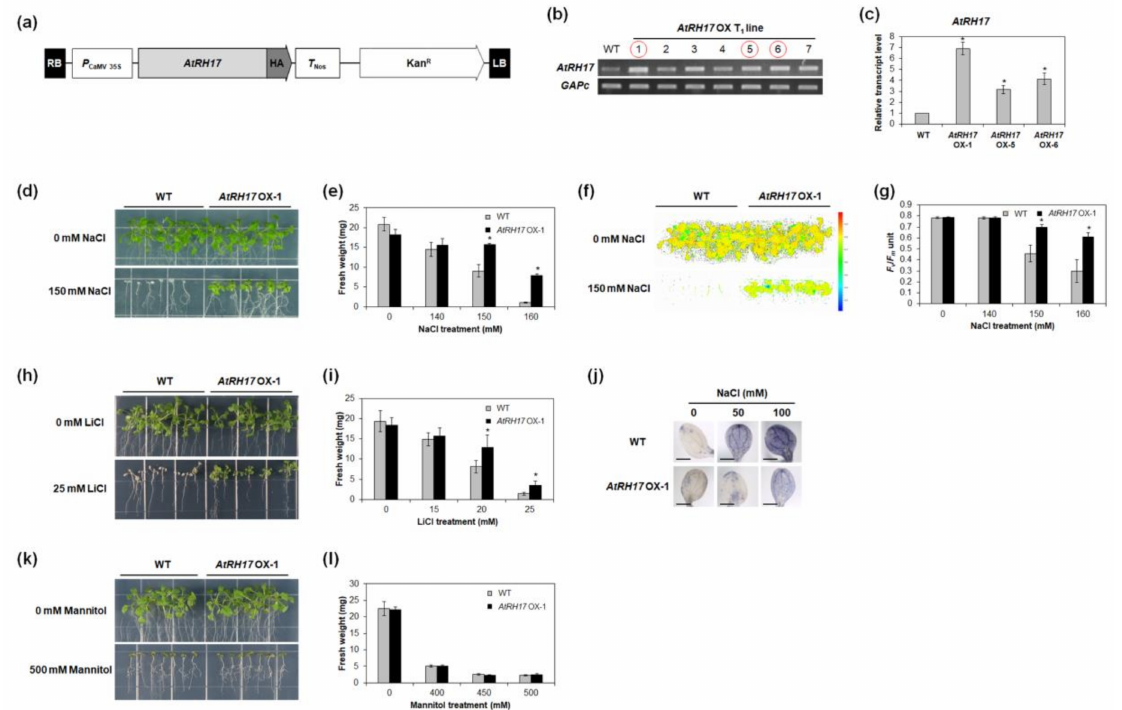
Figure 6. Osmotic-stress response of AtRH17 -overexpressing transgenic plant (OX) seedlings. ( a ) Schematic map of vector for overexpression of AtRH17 . ( b ) Selection of T 1 lines overexpressing AtRH17 by semi-quantitative RT-PCR analysis. Circled lines were selected for further analysis. GAPc was used as an internal control. ( c ) The transcript levels of AtRH17 in AtRH17 OXs were determined by quantitative RT-PCR analysis. GAPc was used as an internal control. Transcript level in WT was set as 1. Three independent reactions were performed for each technical replicate. Two technical replicates were performed for each biological replicate. Error bars represent standard deviation ( n = 6 reactions) and * indicate t -test p < 0.05. ( d ) Responses of WT and AtRH17 OX-1 T 3 seedlings to 0, 140, 150, and 160 mM NaCl. Five-day-old seedlings were transferred onto NaCl-containing MS agar media and photographs were taken 15 days after NaCl treatments. ( e ) FW was measured 15 days after NaCl treatments. ( f ) Fluorescent image of Photosystem (PS) II activity ( F v / F m ) was taken 15 days after NaCl treatments. ( g ) PS II activity ( F v / F m ) was measured 15 days after NaCl treatments using FluorCam. ( h ) Responses of WT and AtRH17 OX-1 T 3 seedlings to 0, 15, 20, and 25 mM LiCl. Five-day-old seedlings were transferred onto LiCl-containing MS agar media and photographs were taken 15 days after LiCl treatments. ( i ) FW was measured 15 days after LiCl treatments. ( j ) Superoxide accumulations in cotyledons of 7-day-old WT and AtRH17 OX-1 seedlings were detected by nitro blue tetrazolium (NBT) staining after 2 h NaCl treatments. Scale bars represent 2 mm. ( k ) Responses of WT and AtRH17 OX-1 T 3 seedlings to 0, 400, 450, and 500 mM mannitol. Five-day-old seedlings were transferred onto mannitol-containing MS agar media and photographs were taken 16 days after mannitol treatments. ( l ) FW was measured 16 days after mannitol treatments. In ( e , g , i , l ), error bars represent standard deviation ( n = 35 plants) and * indicate t -test p < 0.05. Three independent T 1 lines showed similar results, with one shown